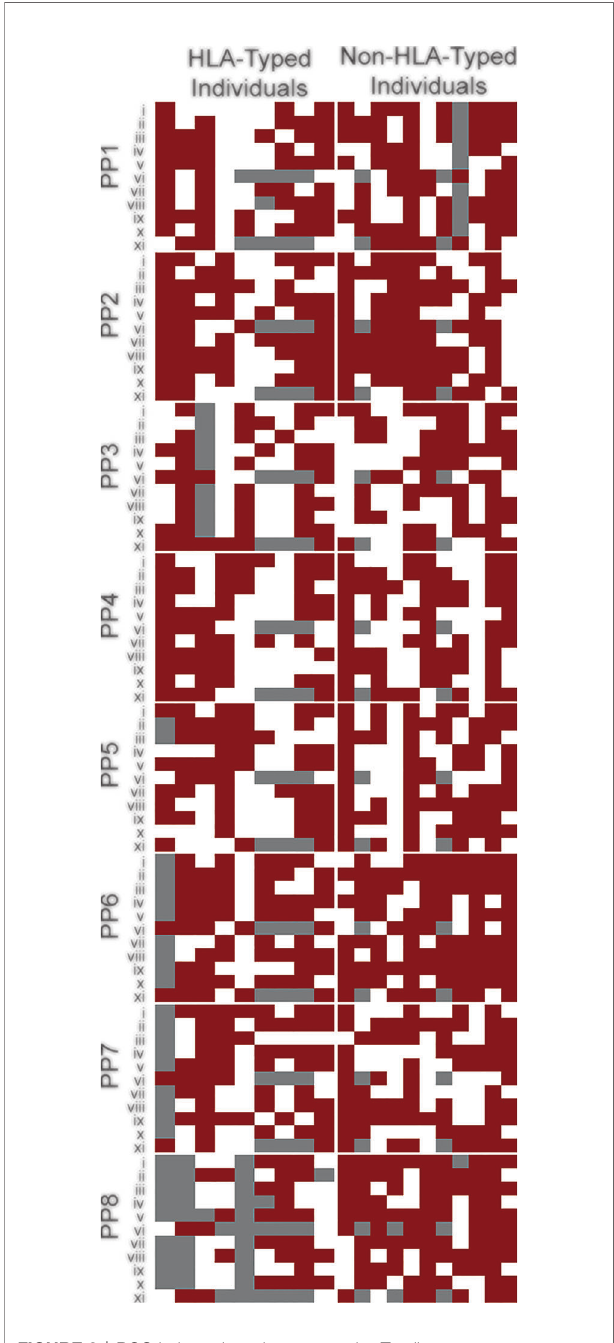
FIGURE 2 | BCG induces broad cross-reactive T cell responses across individuals. Heat map of individuals representing global HLA coverage shows improved SARS-CoV-2 T cell responses when pre-stimulated with BCG peptide. Individual donor T cell responses to the 8 peptide pairs (PP1-PP8) across 11 parameters (i-xi) determined by fl ow cytometry. i – CD8+IFN- g , ii – CD8+TNF, iii – CD8+IL-2, iv – CD8+CD69, v – CD8+Perforin, vi – CD8 +proliferation, vii – CD4+IFN- g , viii – CD4+TNF, ix – CD4+IL-2, x – CD4+CD69, xi – CD4+proliferation. A responder (red) is de fi ned as showing a